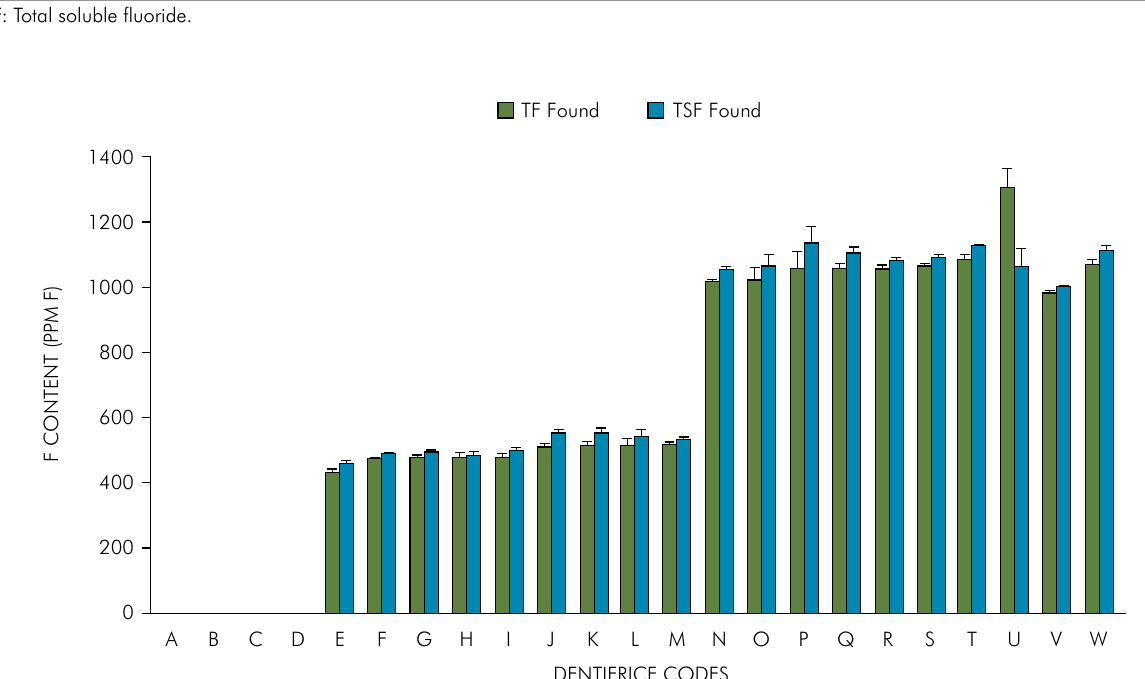
TSF: Total soluble fluoride.